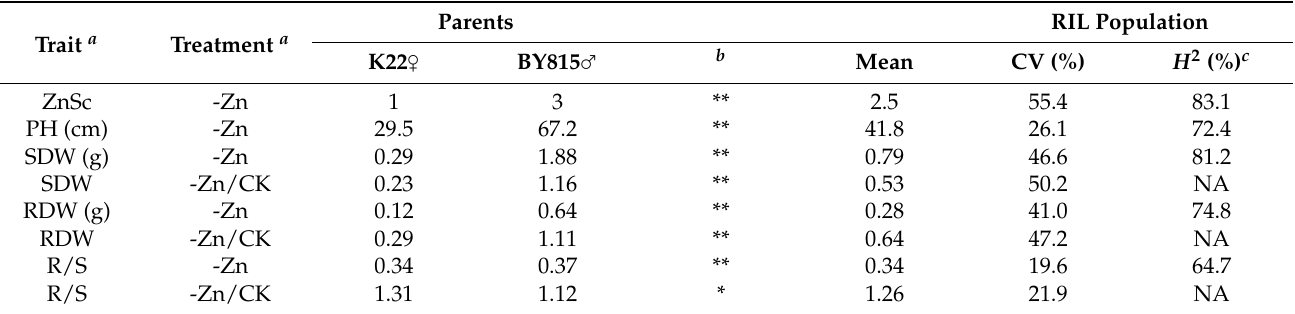
Figure 1. Under the Zn-deficient (- Zn: 0.3 μmol L −1 Zn-EDTA) and Zn-sufficient (CK: 10 μmol L −1 Zn-EDTA) conditions, maize inbred lines K22, BY815, and DAN340 (from left to right) were grown hydroponically for 21 days after transplanting. Representative shoots are displayed. Table 1. Phenotypic variations of the traits associated with Zn deficiency tolerance in the parental lines K22 and BY815, and K22×BY815 RIL population.